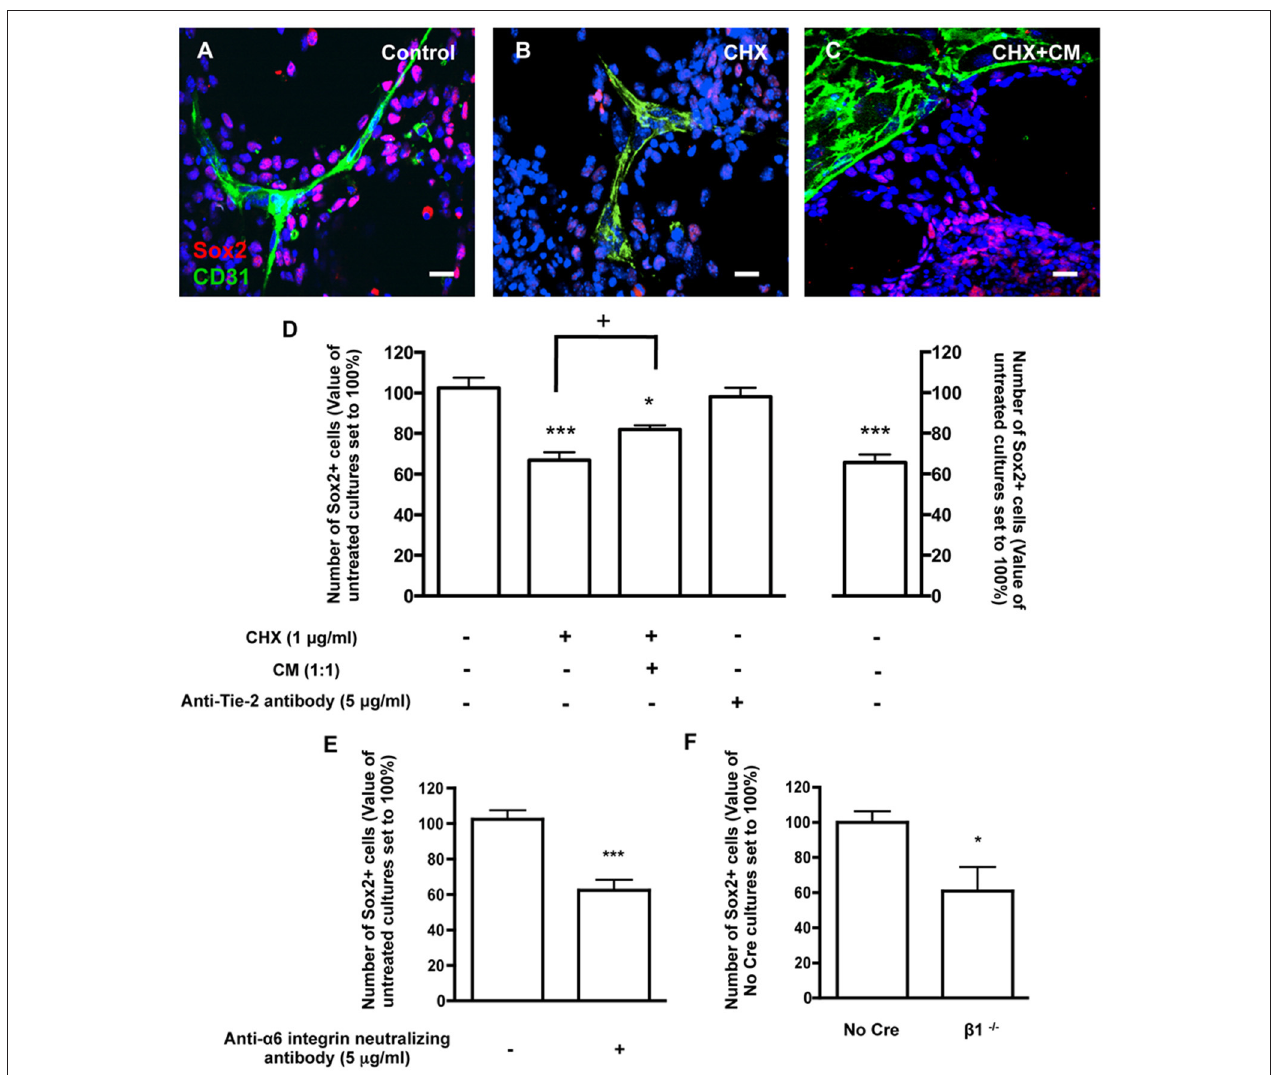
FIGURE 4 | Contacts between SVZ cells and BEC promote SVZ cell stemness. (A–C) Representative confocal digital images depicting stem-like cells in BEC and SVZ cells cocultures (green staining for CD31, red staining for Sox2 and Hoechst 33342 staining in blue). (A) Control cocultures. (B) Cocultures with CHX-treated BEC, in SFM. (C) Cocultures with CHX-treated BEC, in SFM and BEC-CM (1:1). Scale bars, 20 µ m. (D) Left: Bar graphs show the number of Sox2 + cells as a percentage of the total cells contacting BEC. Right: Graph displays the number of Sox2 + cells as a percentage of the total number of cells in the pseudomonolayer of differentiation, i.e., non-contacting BEC. Control values were normalized to 100%. * P < 0.05, *** P < 0.001, using one-way ANOVA. + P < 0.05 using the unpaired t -test for comparison to cocultures with CHX-treated BEC. (E,F) α 6 β 1 integrin mediates stemness induced by contact with BEC. Bar graph shows the number of Sox2 + nuclei as a percentage of the total cells contacting BEC in Control cocultures, in anti- α 6 integrin neutralizing antibody-incubated cocultures ( E , *** P < 0.001 using the unpaired t -test for comparison to Control cocultures) and in cocultures with β 1 − / − SVZ cells ( F , * P < 0.05 using the unpaired t -test for comparison to No Cre